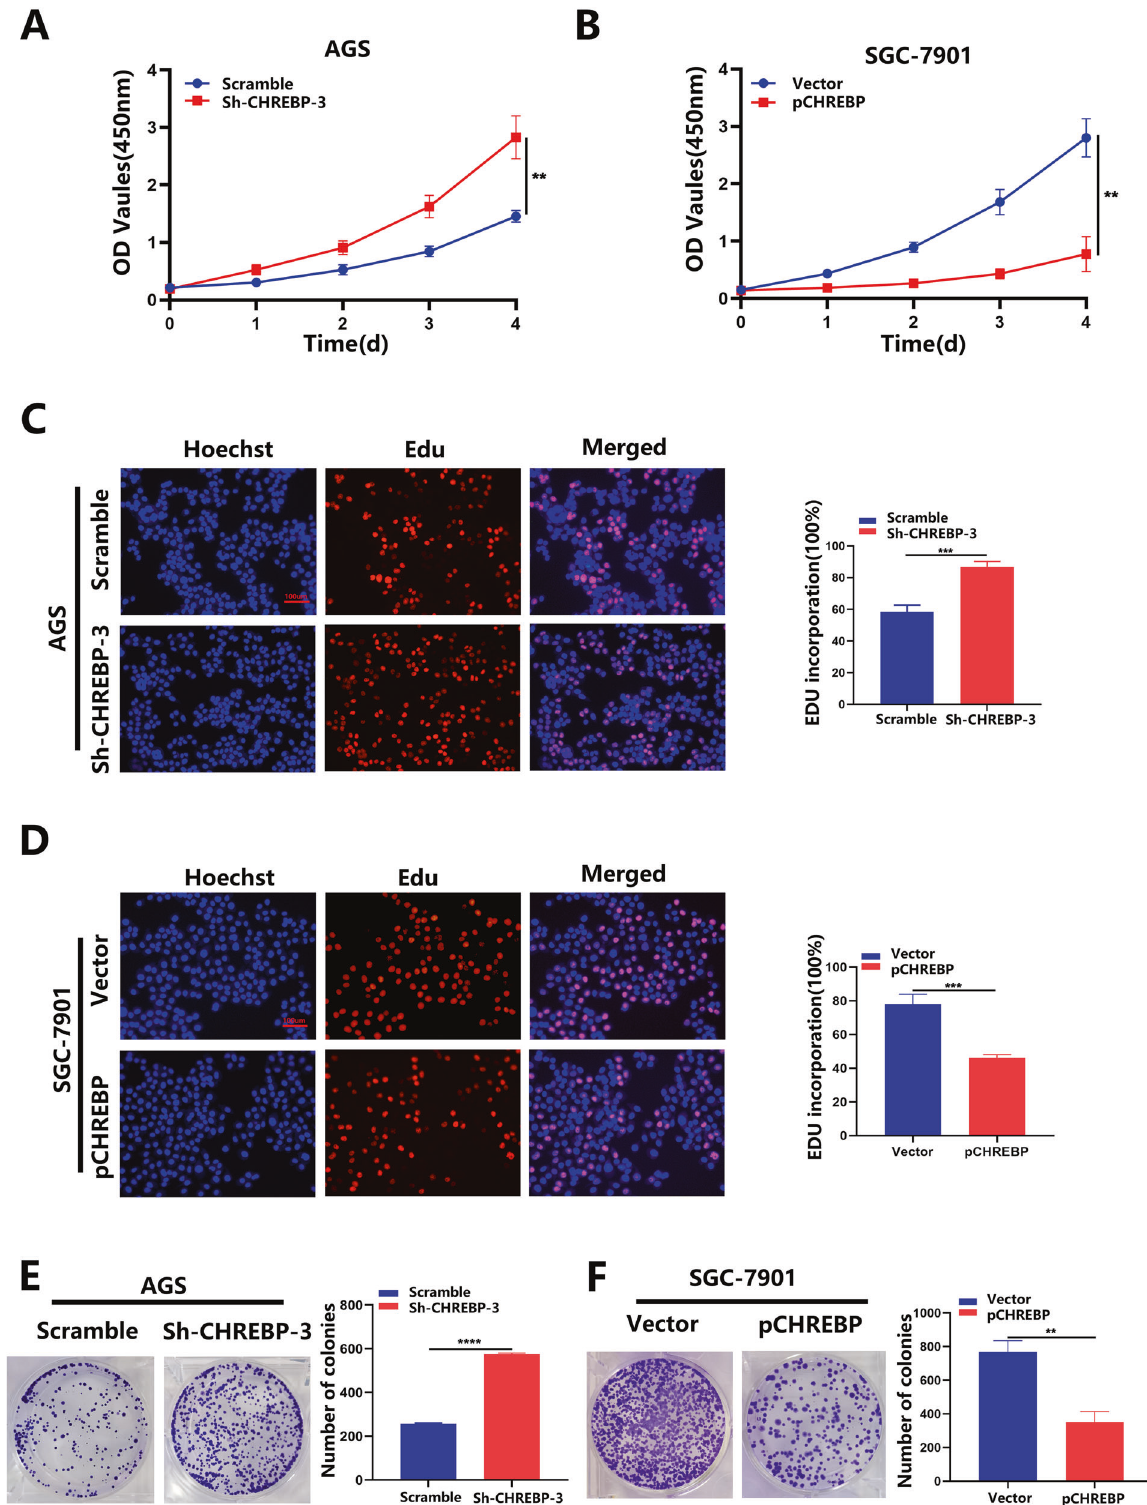
Fig. 3 The effect of CHREBP on GC cell proliferation in vitro. A , B A CCK-8 assay was conducted to investigate the vitality of GC cells after CHREBP knockdown or overexpression. C , D An EdU assay was employed to testify proliferation of cells transfected with Sh-CHREBP or overexpressing CHREBP (scale bar: 100 μ m). E , F A colony formation assay was conducted to examine the proliferation of Sh-CHREBP- transfected or CHREBP overexpression-transfected GC cells.